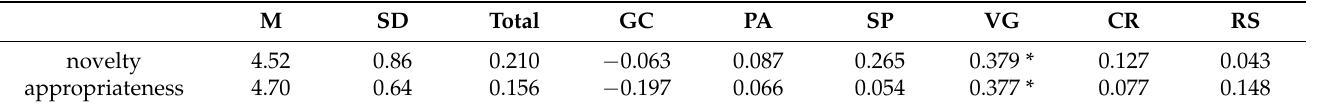
Table 4. Correlation between the quantity of utterances of the elected leader and the indicators of group